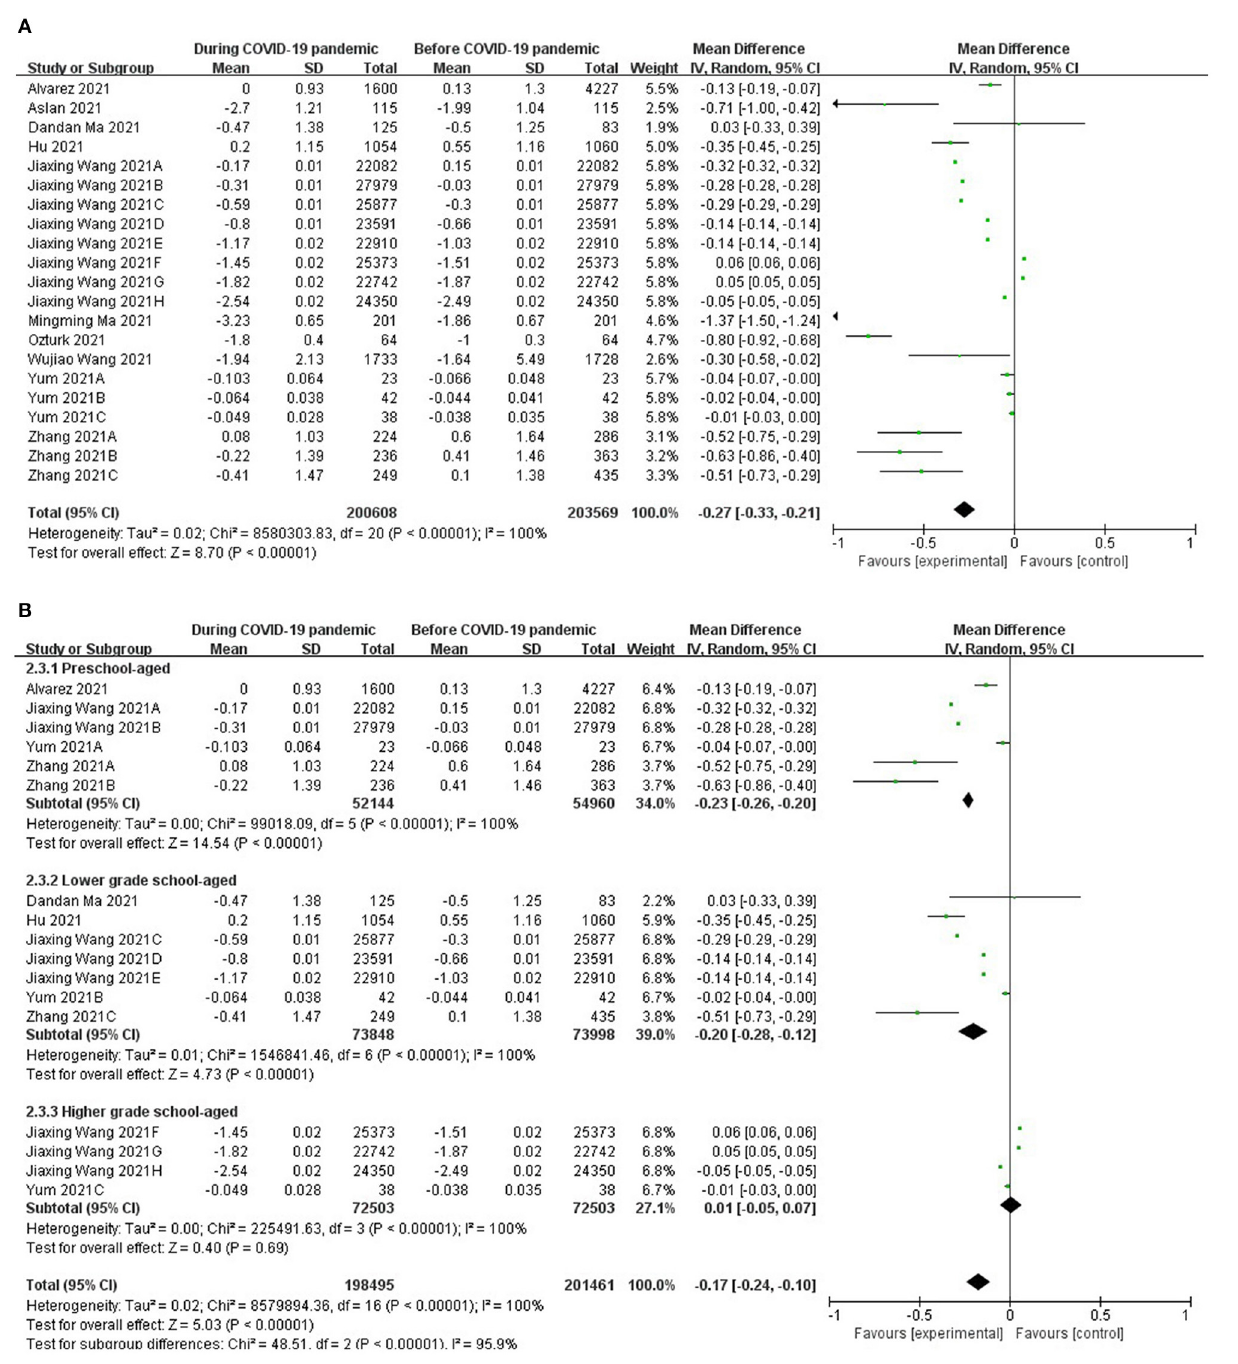
during COVID-19 pandemic home quarantine. Other studies also reported this conclusion. He et al. (8) have shown in their study that myopia incidence was 23% less in children with an additional 40 min of outside activity. Aslan et al.